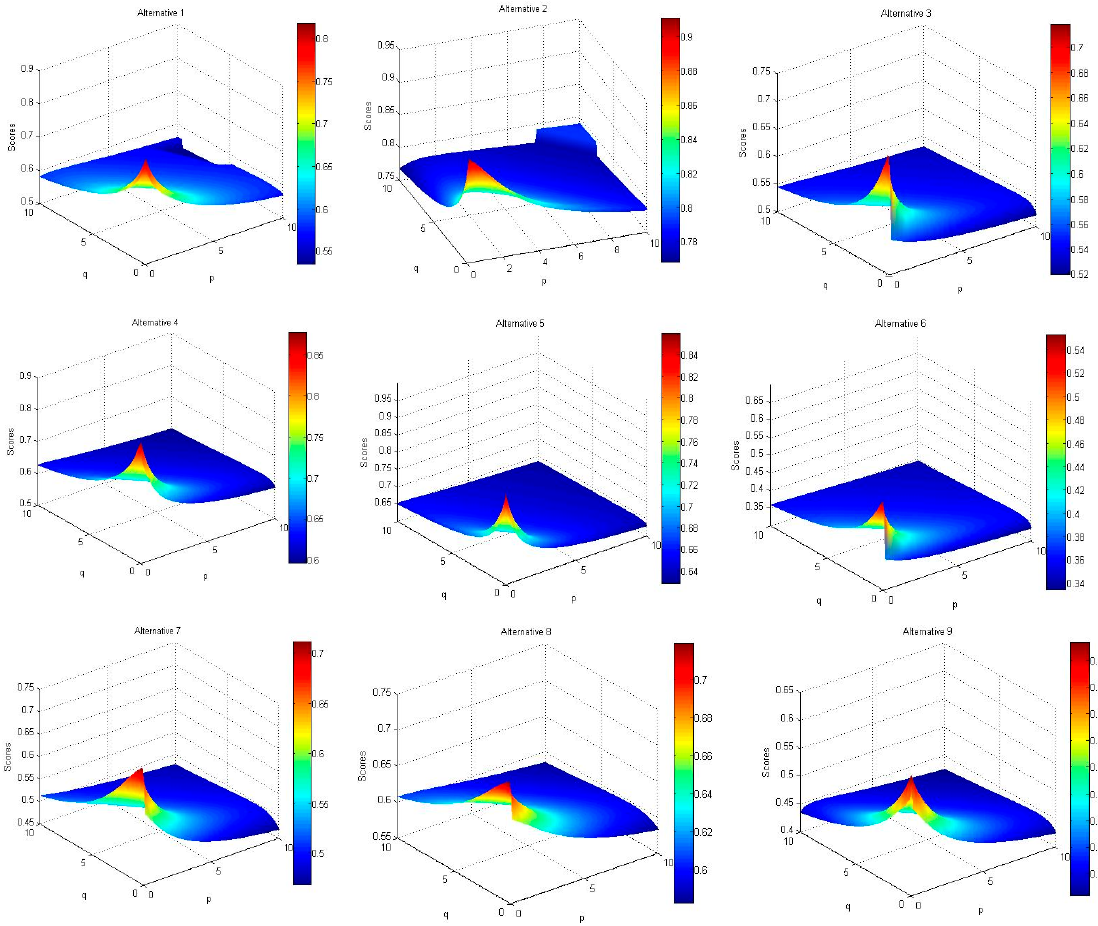
Figure 4. Scores obtained by the HFWHM operator (p ∈ [0,10], q ∈ [0,10]).